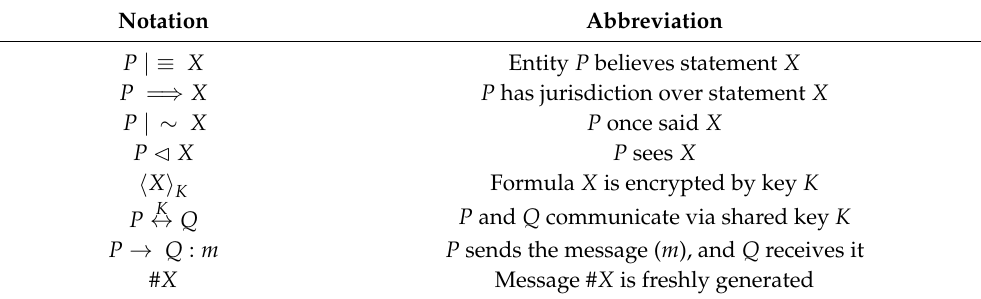
Table 2. BAN logic notations and respective abbreviations